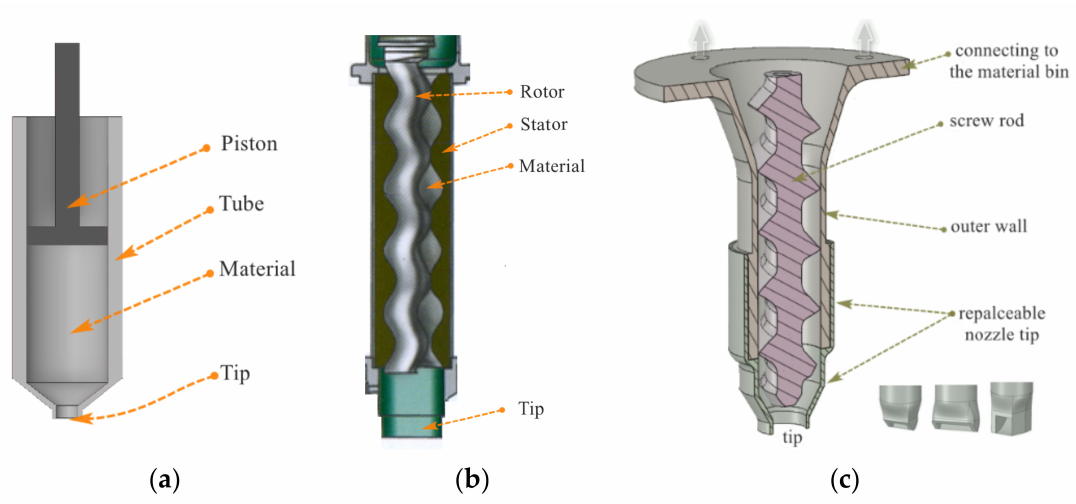
Figure 8. Three common types of nozzle units: ( a ) a piston extruder, ( b ) a screw pump, and ( c ) a direct screw with replaceable nozzle